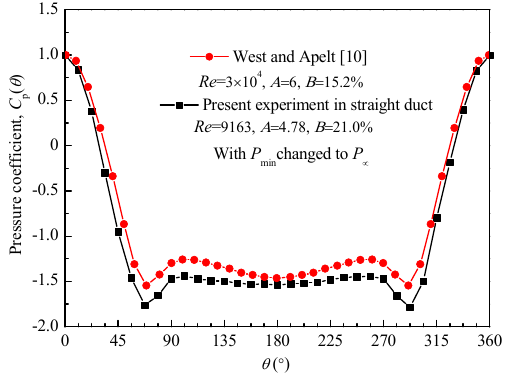
Figure 5. Validation of the experimental method.